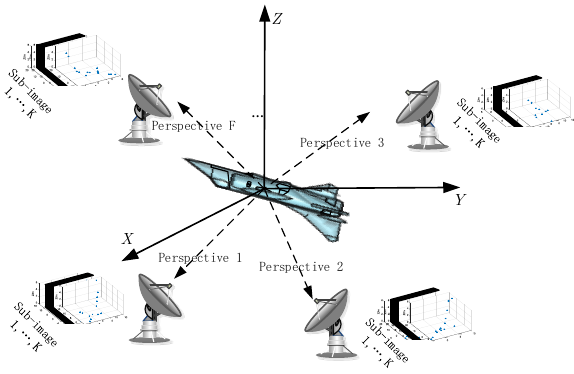
Figure 4. The model of multiple perspectives.